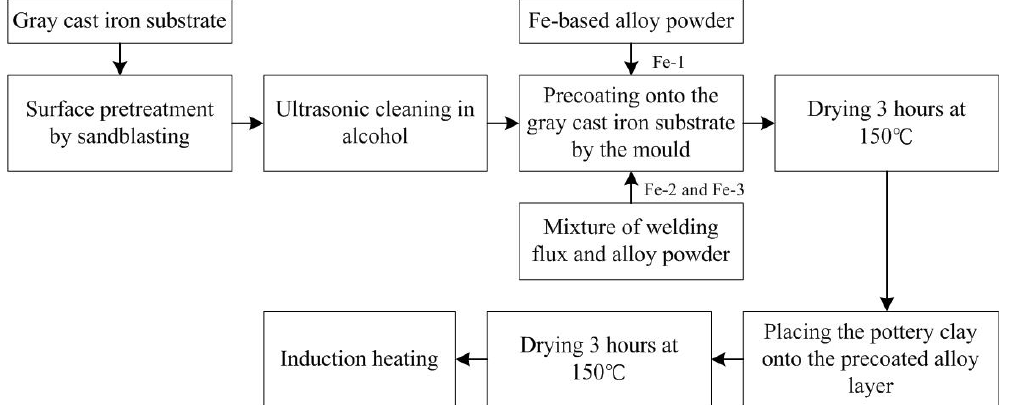
Figure 1. Induction cladding experiment procedure.